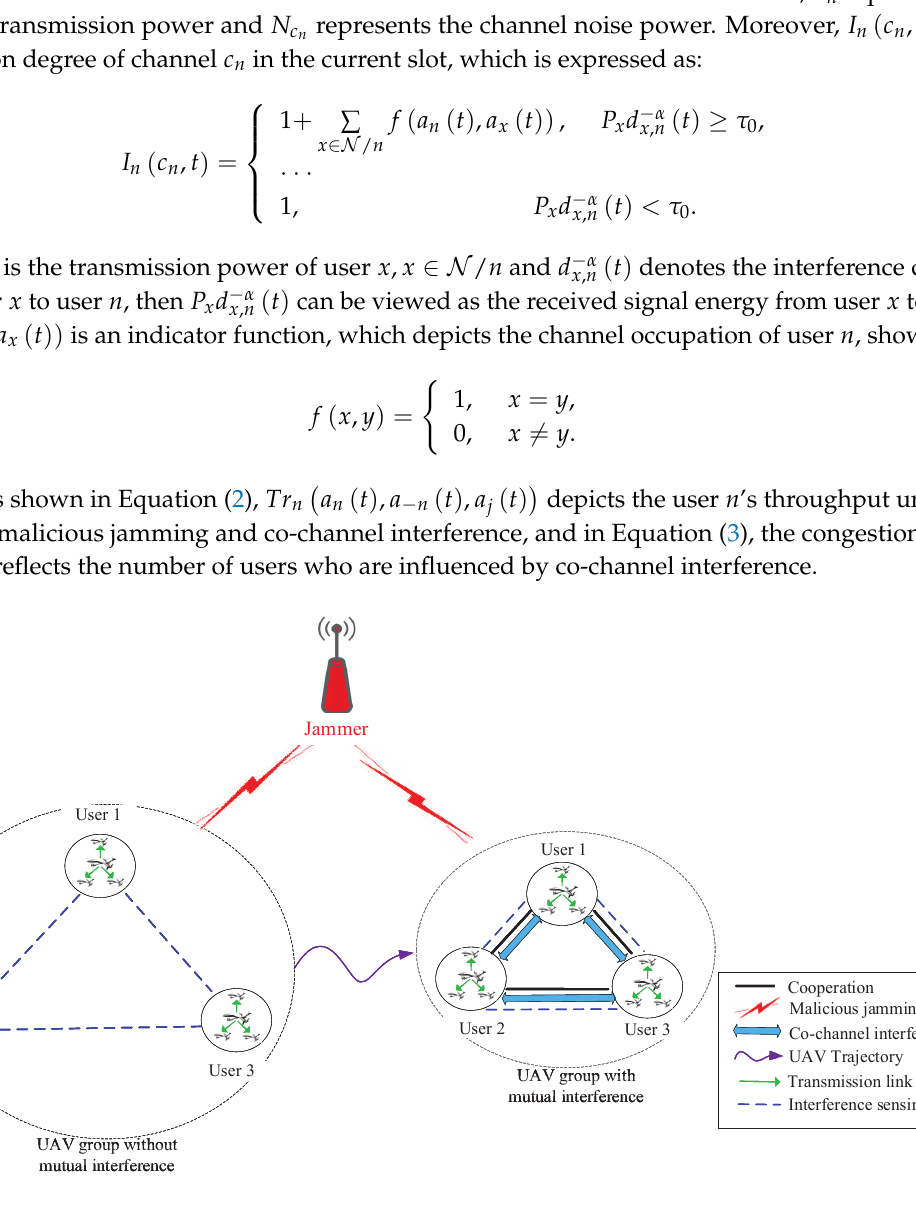
Figure 1. Cooperative anti-jamming UAV communication